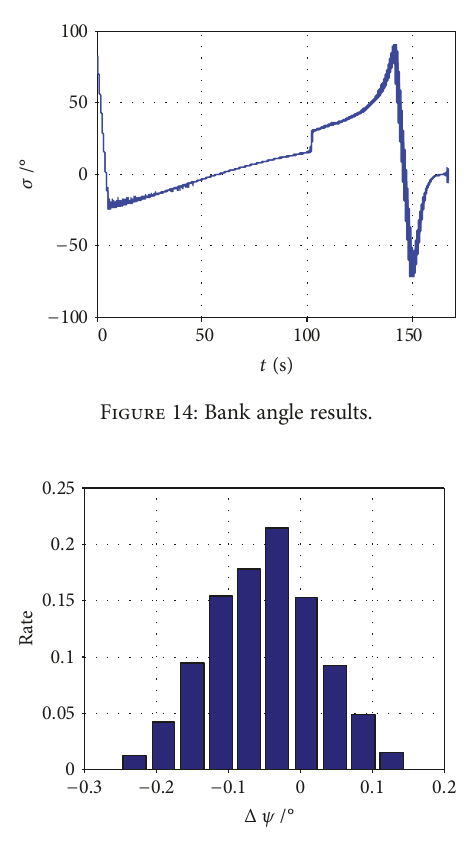
Figure 18: Distribution of attacking time